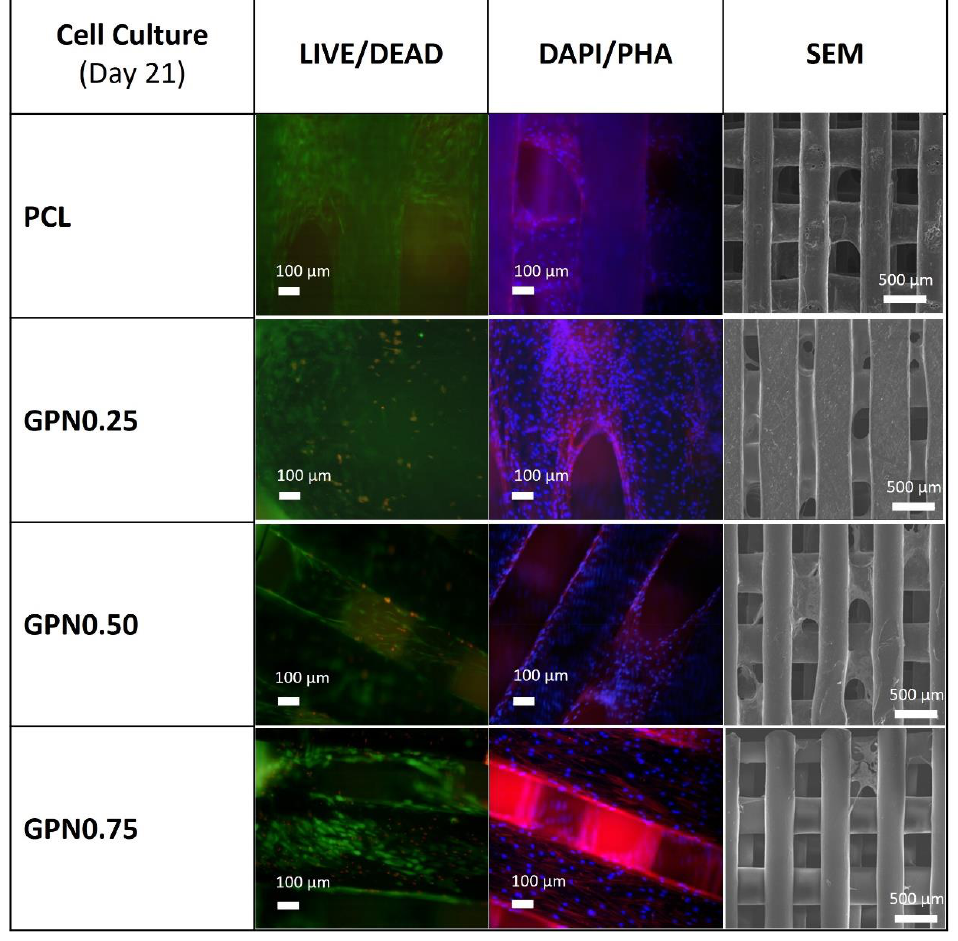
Figure 8. Biological in vitro testing of scaffolds with BM MSC: Cell viability, distribution and mor- phology assessment (at day 21) through LIVE/DEAD assay (first column), DAPI/PHA staining (sec- ond column), and SEM imaging (third column).